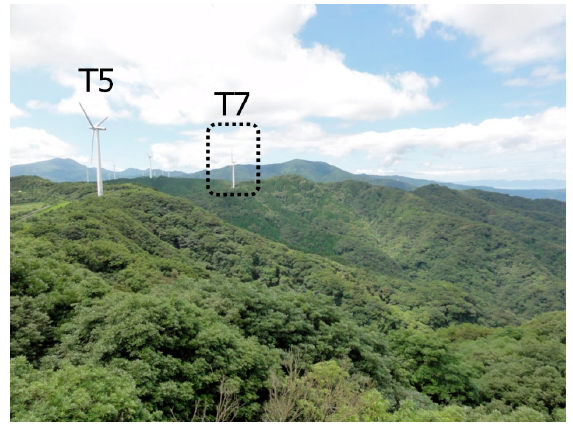
Figure 9. Photo of the area where T7 is located.